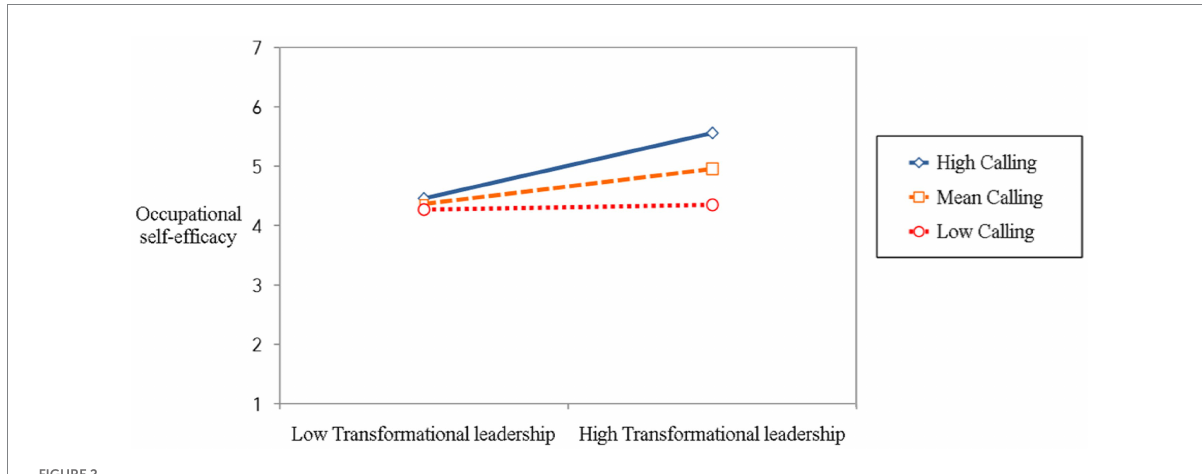
FIGURE 2 The interaction between transformational leadership and the calling on occupational self-efficacy.